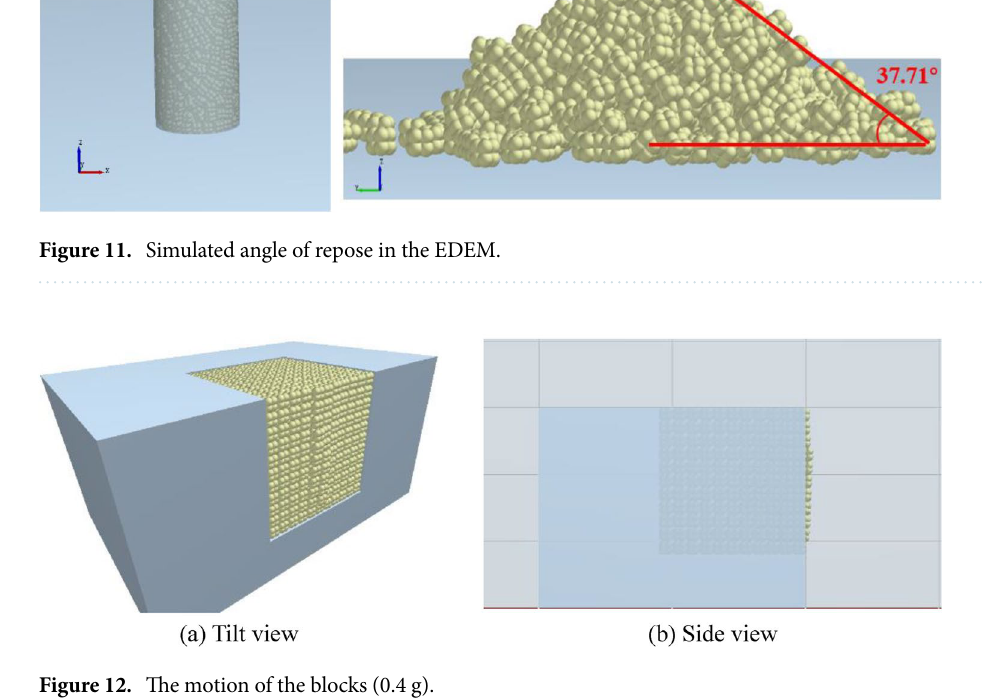
Figure 12. The motion of the blocks (0.4